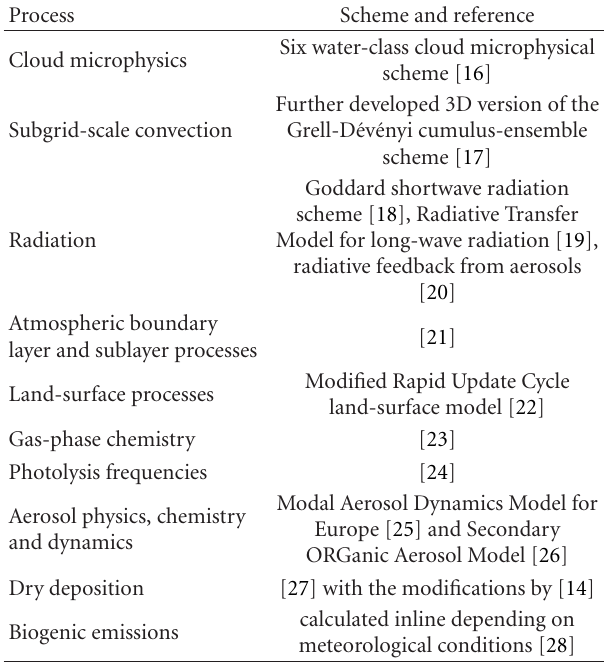
Table 1: Parameterizations used in this